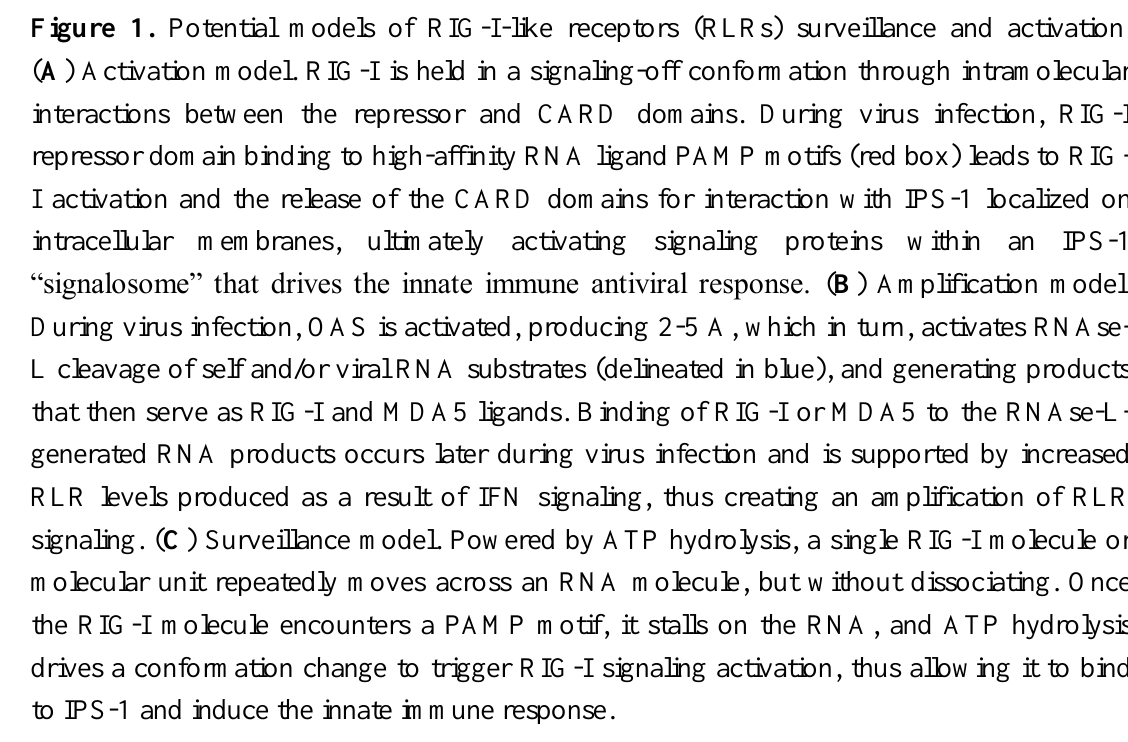
Figure 1. Potential models of RIG-I-like receptors (RLRs) surveillance and activation. ( A ) Activation model. RIG-I is held in a signaling-off conformation through